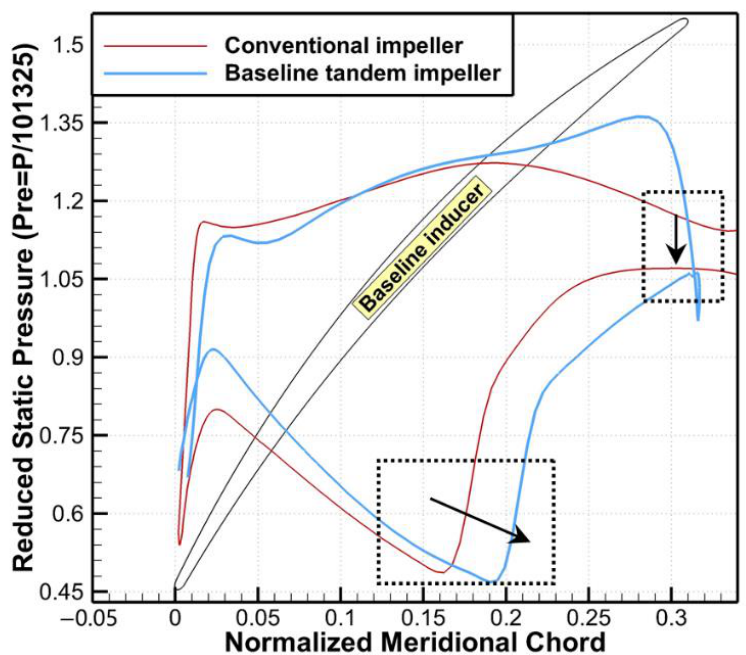
Figure 13. Comparison of the loading distribution at a 95% span.